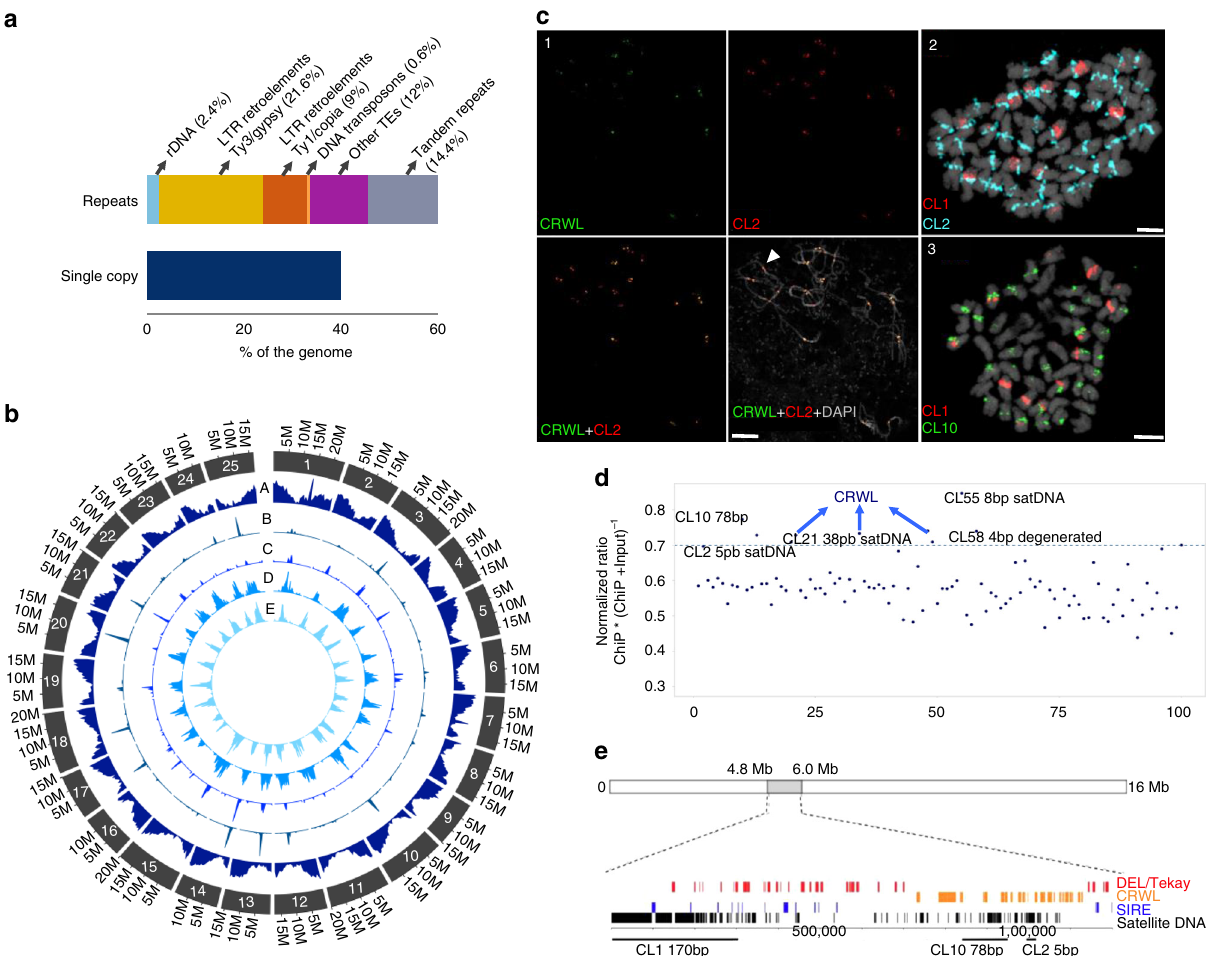
Fig. 1 Repeated elements abundance in white lupin genome. a Proportion of single copy and repeated sequences for the different classes of repeats. b Density distribution along the chromosomes of the repetitive classes. A. genes, B. CRM, C. satDNA, D. Tekay, and E. SIRE. Density is represented in 0.5 Mb bins. c FISH mapping of the main repeats by super-resolution microscopy (3D-SIM). (1) Co-localization of CRWL and CL2 satDNA on centromeric regions of meiotic (pachytene) chromosomes. (2 – 3) Distribution of the most abundant satellite DNAs CL1, CL2, and CL10 in somatic metaphase chromosomes. Bars are 10 µ m (1) and 2 µ m (2 and 3). d LalbCENH3-ChIPseq reads mapped against the fi rst 100 RepeatExplorer clusters of the WL genome. The main centromeric sequences found in LalbCENH3-ChIPseq are highlighted. e Typical centromere composition of a WL chromosome, chromosome 14. Source data underlying Fig. 1d are provided as a Source Data fi